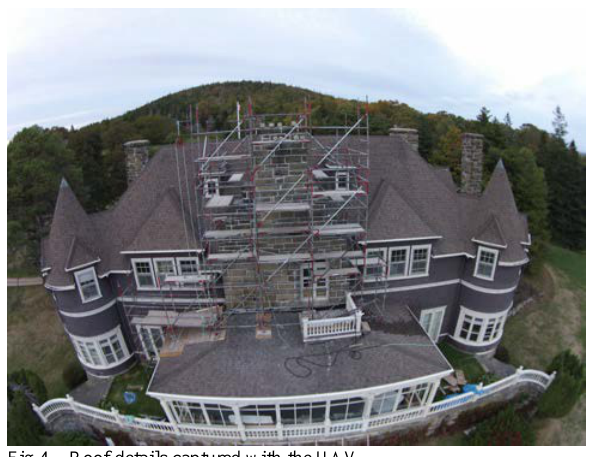
Fig.4 – Roof details captured with the